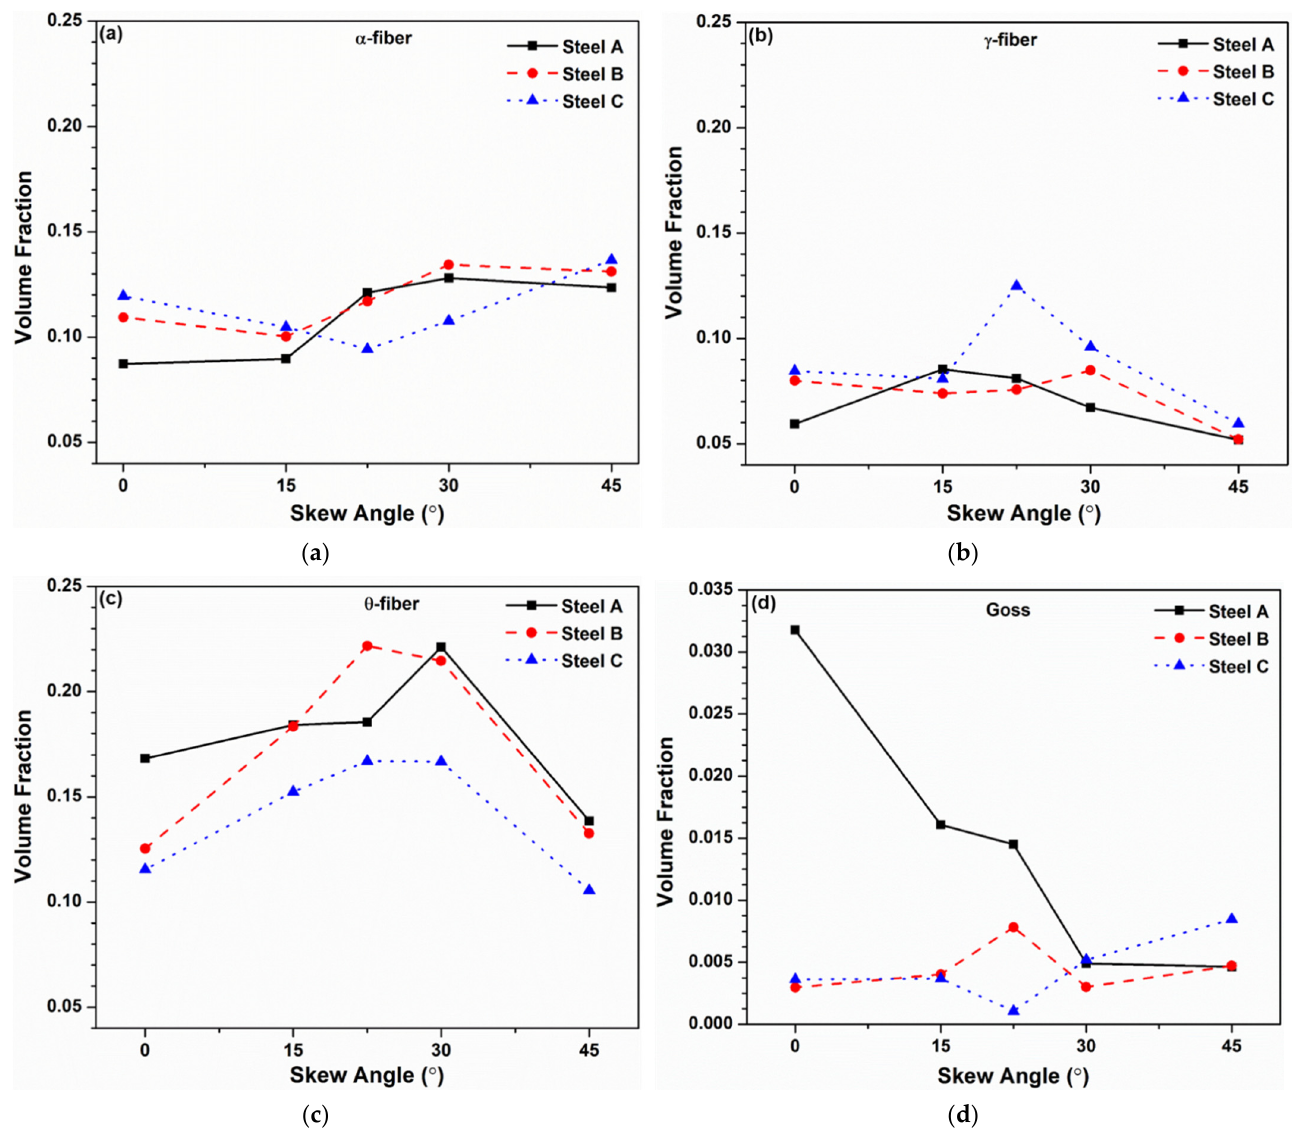
Figure 9. Variations of the volume fractions of common texture fibers, ( a ) α -fiber, ( b ) γ -fiber, ( c ) θ -fiber and the Goss component ( d ), after skew cold rolling and annealing (unidirectional feeding).